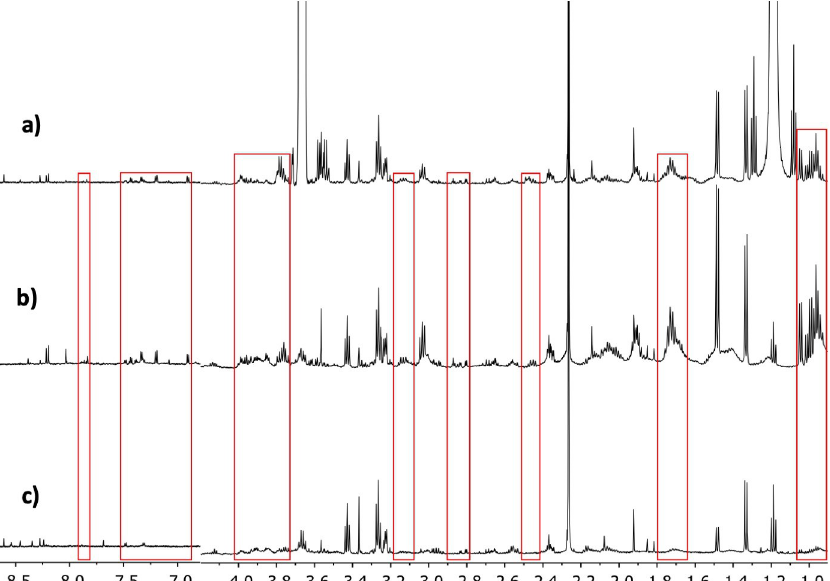
Fig 2. Comparison of the spectra obtained from the three different PBMC processing methods evaluated for metabolomic profiling. a) Ultrasound and Ultrafiltration Method, b) Ultrasound Method, c) Folch Method. The differences in specter regions between methods are seen in red